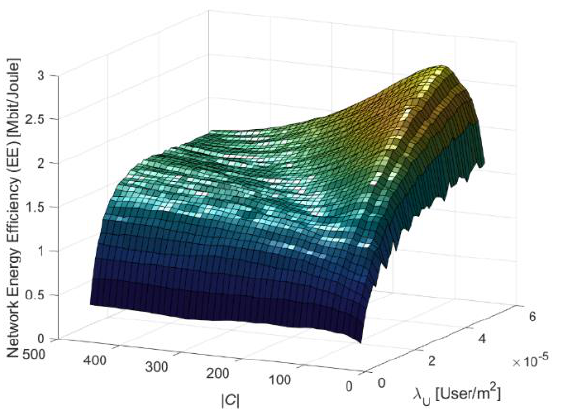
Figure 23. The impact of the total number of available channels in each macrocell (i.e., |Ϲ| ) and the density of users ( 𝜆 𝑈 ) on the network EE. density of users ( λ U ) on the network